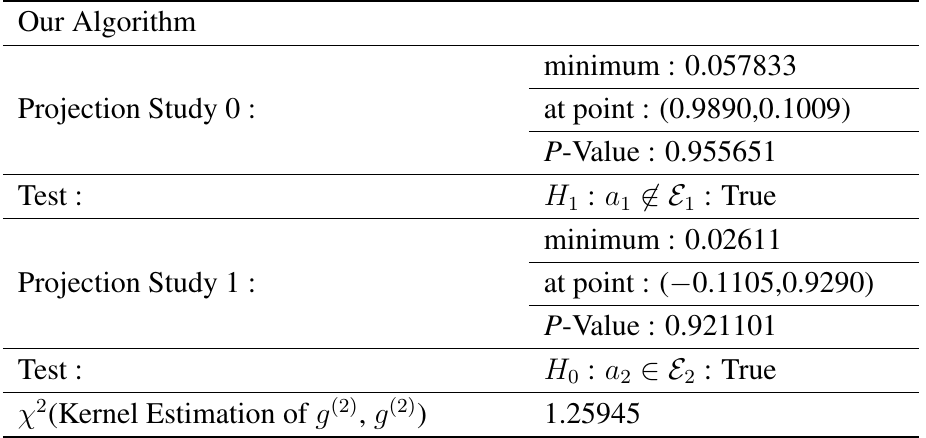
Table 4. Simulation 2: Numerical results of the optimisation.